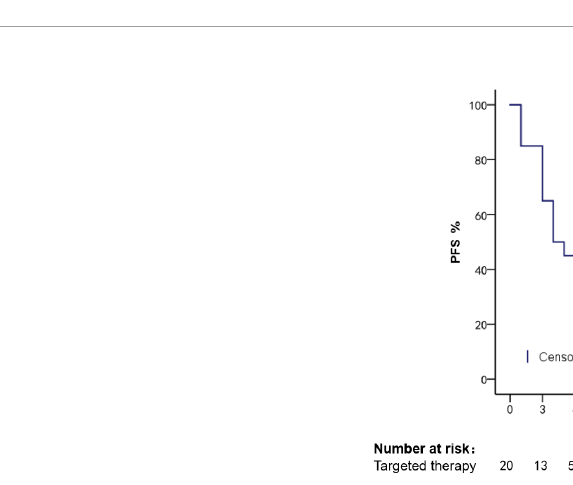
FIGURE 7 PFS in patients with Her-2 overexpression after targeted